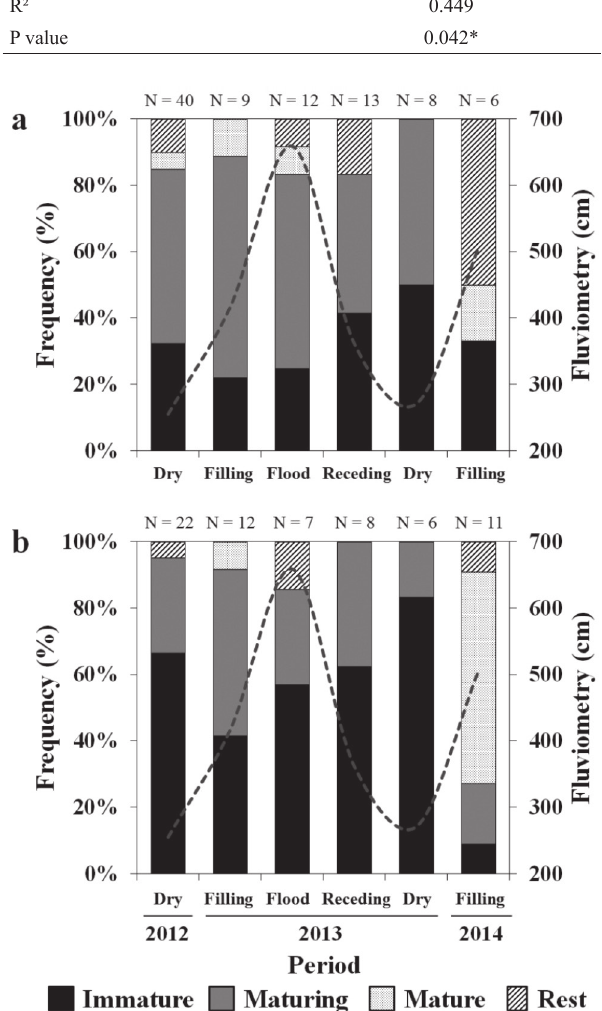
Fig. 5. Relative frequency (%) of the different gonadal maturation stages of the red-tailed catfish Phractocephalus hemioliopterus specimens collected from the Xingu River in Pará, Brazil. a. males; and b.